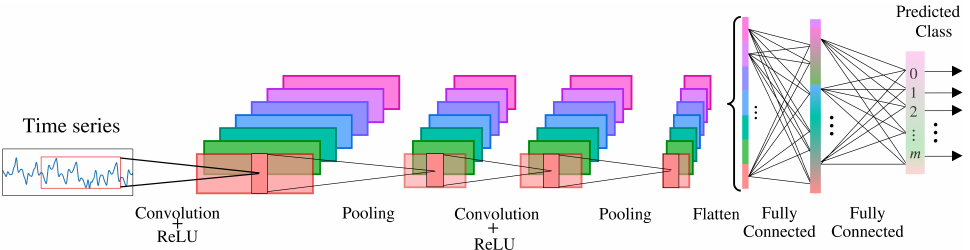
Figure 3. Representative diagram of the structure of CNN for the classification of time series, where m is the number of classes.